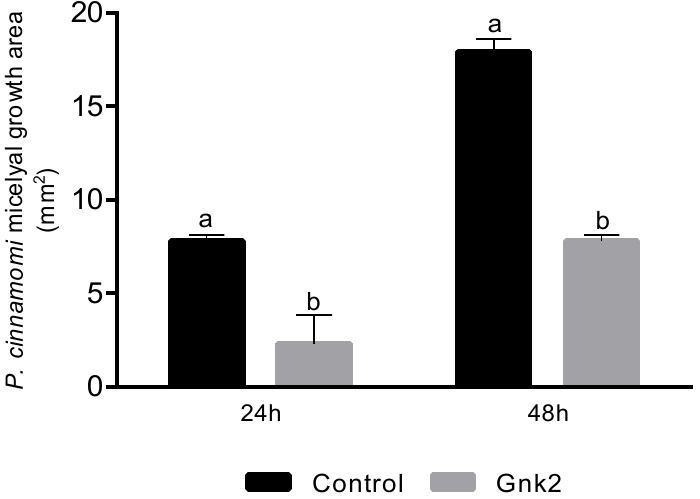
Figure 5. Mycelia area (mm 2 ) of P. cinnamomi growth in PDA under control treatment (only with bu ff er solution) and Cast_Gnk2-like pure protein treatment (250 µL/plate and 0.5 mg/mL) in Petri plates after 24 and 48 h at 25 °C in darkness. Results are shown as means ± SEM. Signi fi cant di ff er- ences are shown as di ff erent le tt ers ( t -Test, p < 0.05).